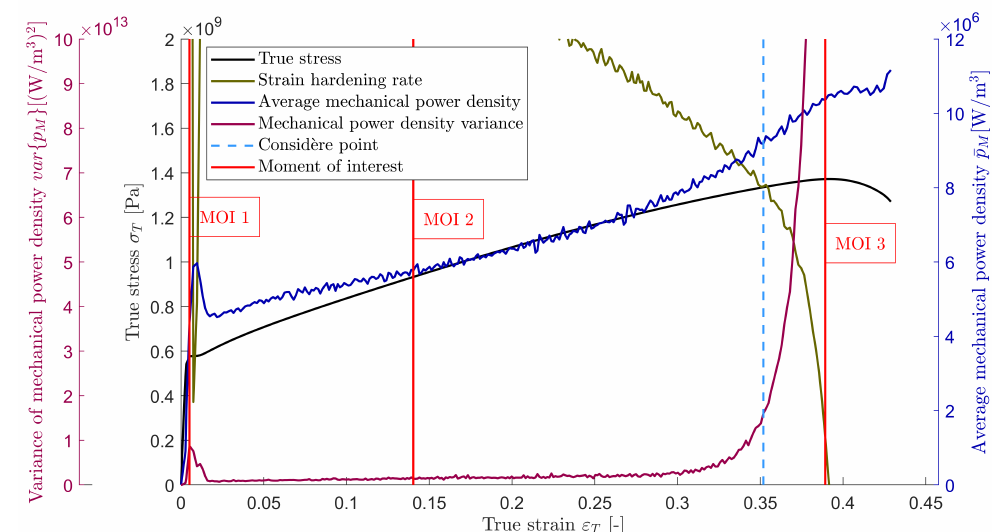
Figure 13. True stress vs. true strain, strain hardening rate, the mechanical power and its variance evolution during tensile testing on the Inconel-625 alloy. The vertical dashed line indicates the Considère point. The solid vertical lines correspond to the moments of interest (MOI) shown in Figure